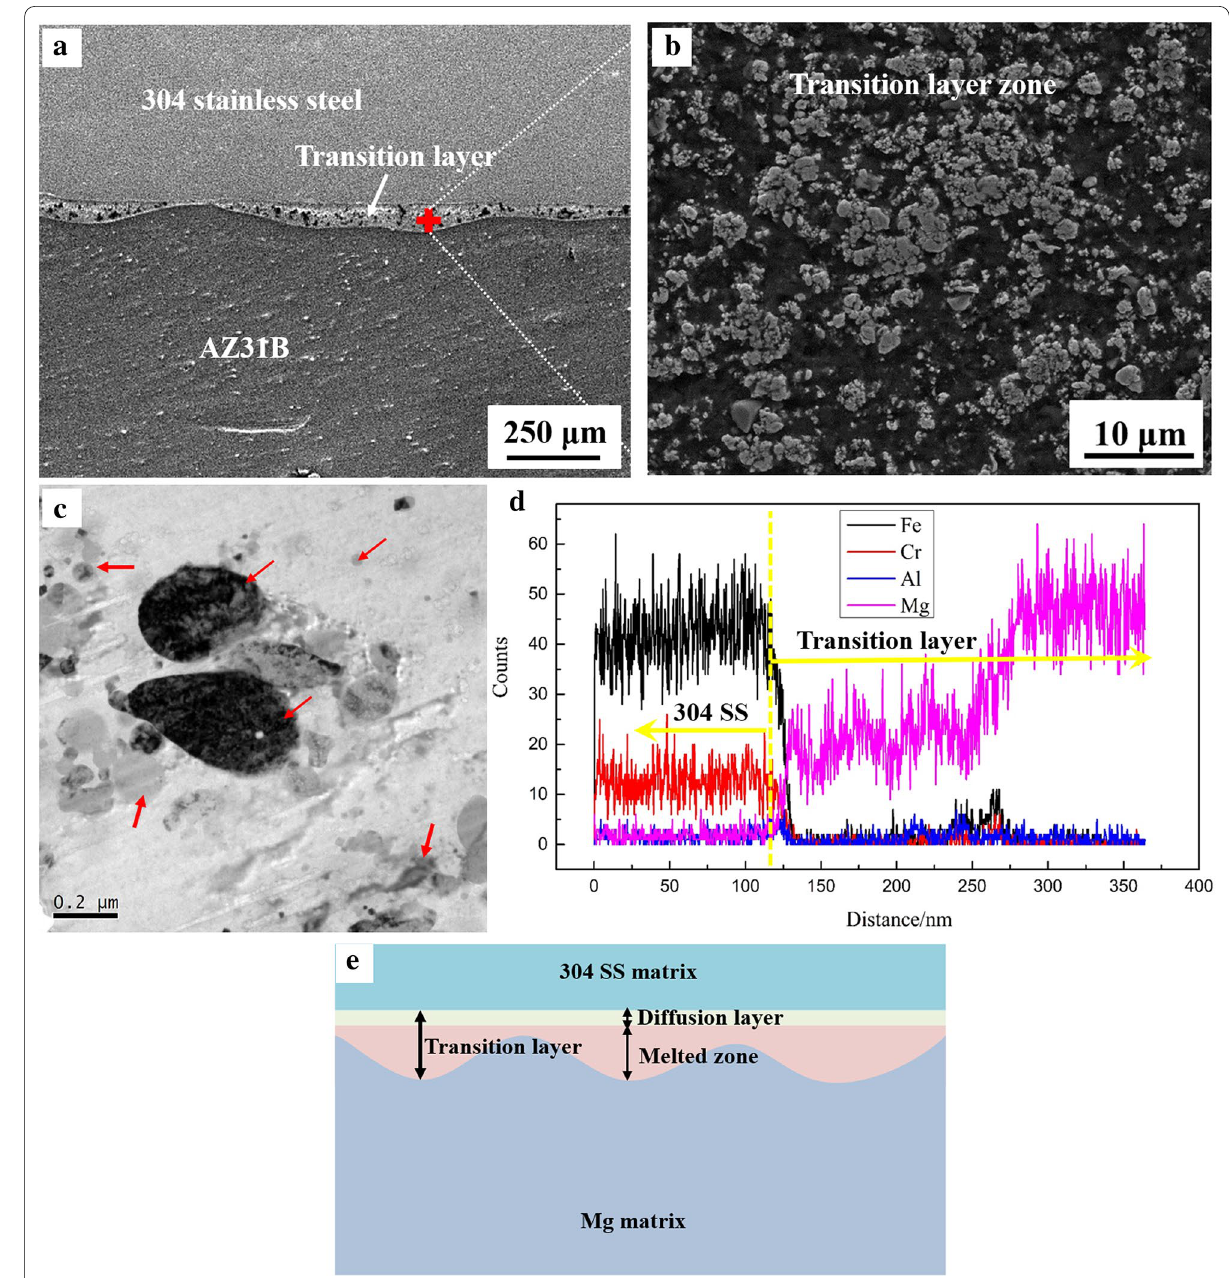
Figure 5 Half-wave-like interface of 304SS/AZ31B explosive welded clad plate: ( a ) BSE image of the bonding interface; ( b ) Enlarged BSE image at the interlayer zone; ( c ) TEM images at the interlayer zone; ( d ) EDS line scanning perpendicular to the bonding interface between 304SS and the interlayer zone; ( e ) Schematic of the bonding